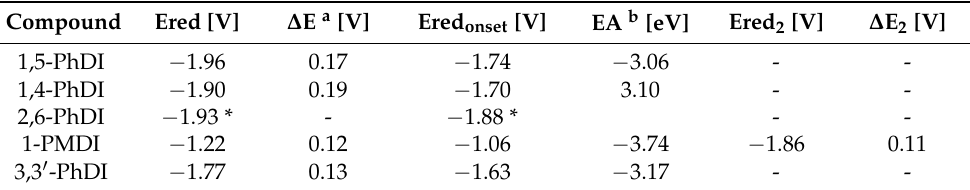
Figure 2. Cyclic voltammograms of 1-PMDI ( a ) and 1,4-PhDI ( b ), registered in 0.1 M Bu 4 NPF 6 /DCM electrolyte. Scan rate of 0.1 V/s. Table 3. Electrochemical data collected for investigated compounds dissolved in 0.1 M Bu 4 NPF 6 /DCM electrolyte.